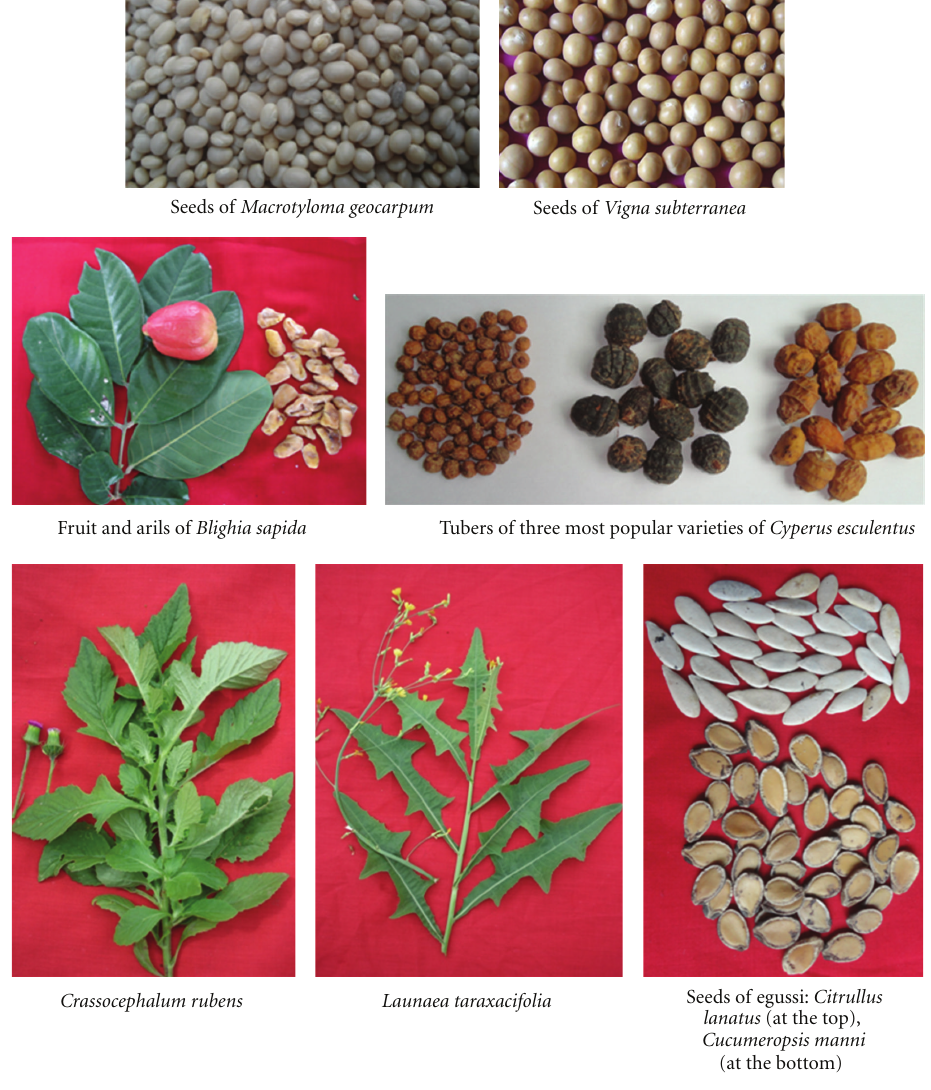
Figure 3: Pictures of selected neglected and underutilized crop species in